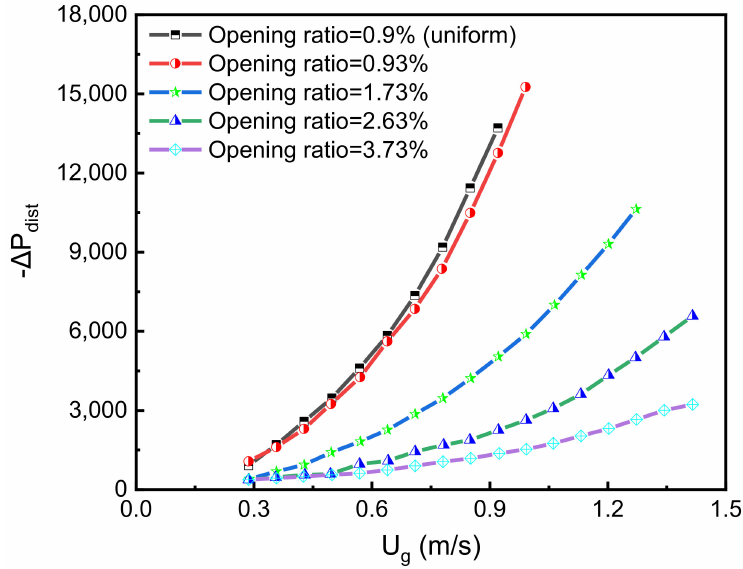
Figure 10. Influence of superficial gas velocity on pressure across the different distributor designs. Adopted from Son et al.